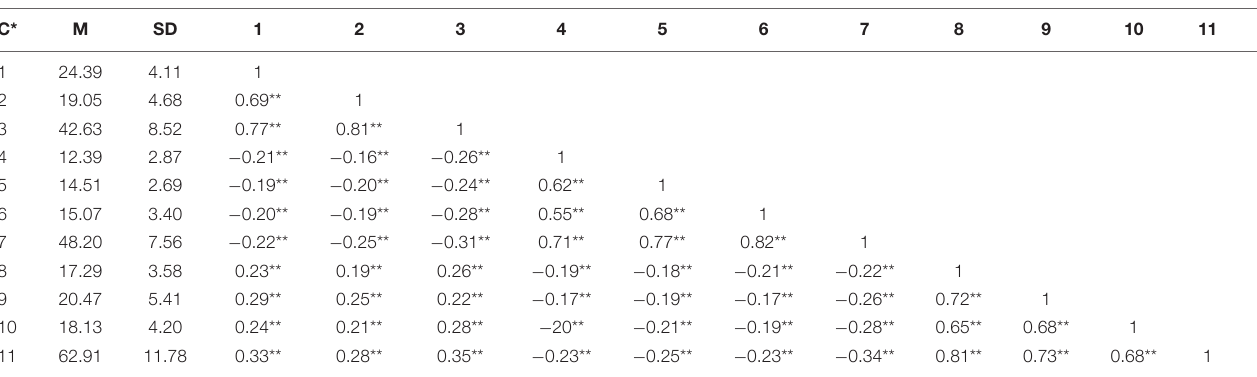
TABLE 9 | Pearson correlation matrix among the constructs and the